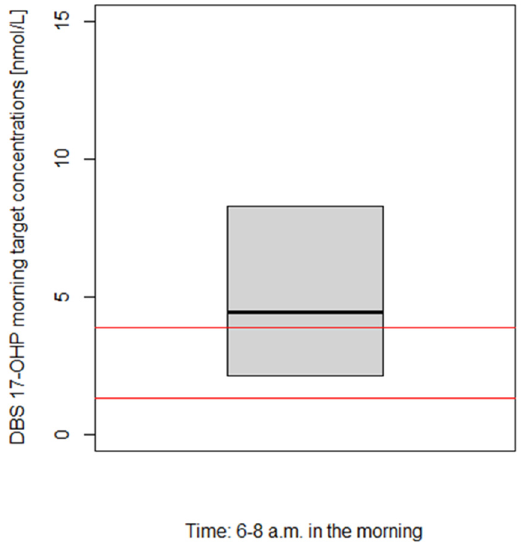
Figure 6. Derived dried blood spot (DBS) 17 α -hydroxyprogesterone (17-OHP) target morning concentration range (=model-predicted physiological range multiplied by 3 to 5). Interquartile range (gray box) and median (black line) of the derived DBS 17-OHP target morning concentrations (see step (C1) in text). Red lines: Calculated expected target DBS 17-OHP concentration range in the morning (see step (C2) in text).